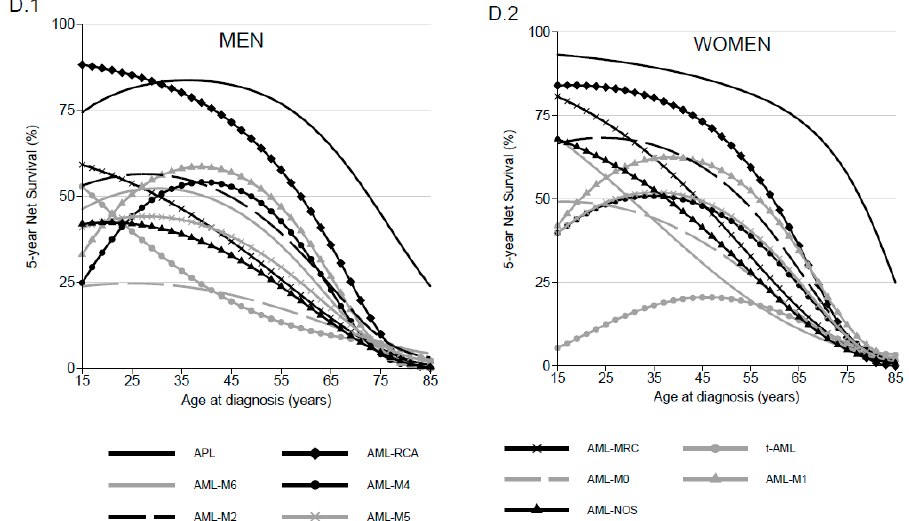
Figure 1. Net survival (NS) and excess mortality rate (EMR) for patients diagnosed from 1995 to 2015 according to AML subtype and sex: Net survival probabilities (%) over time since diagnosis in years in men ( A.1 ) and in women ( A.2 ); dynamics of the excess mortality rate (deaths per person-year) over the time since diagnosis in years in men ( B.1 ) and in women ( B.2 ); one-year net survival probabilities (%) over the age of diagnosis in men ( C.1 ) and in women ( C.2 ); five-year net survival probabilities (%) over the age of diagnosis in men ( D.1 ) and in women ( D.2 ). Table 3. Estimated net survival in percent (and 95% confidence interval) at 1, 5 and 10 years after AML diagnosis according to AML subtype and sex for all ages and with age fixed at 25, 50 and 75 years old. Results of the flexible excess mortality model retained in each AML subtype and sex with the covariate of age at diagnosis fixed to values equal to 25, 50 and 75 years old.